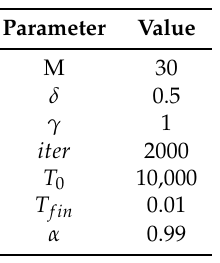
Table 1. Default experiment settings.